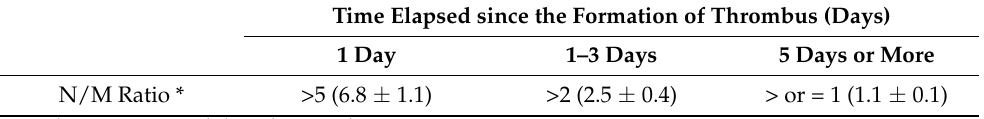
Table 4. DVT timing according to N/M ratio. Time Elapsed since the Formation of Thrombus